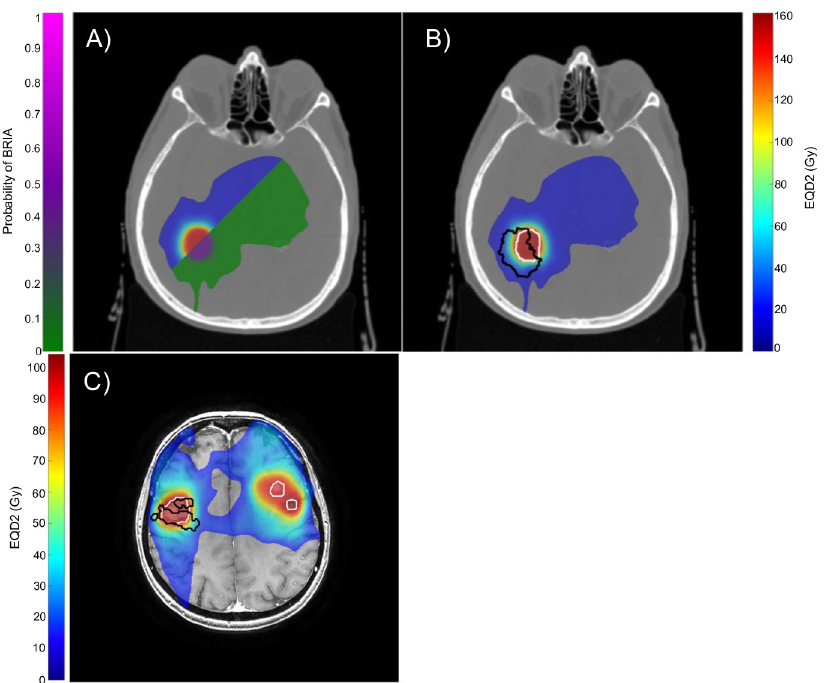
Fig 4. Agreement of the logistic model with the radiation dose map and observed BRIA ROI for two representative patients. Voxel EQD2 is represented by the blue to red scale. Panel A displays the cumulative voxel EQD2 map alongside the estimated probability of BRIA as predicted by the logistic regression model (green to pink scale) in a representative patient. Panel B demonstrates the cumulative voxel EQD2 map overlaid with the PTV (white) and the observed BRIA ROI (black) for the same patient. Panel C illustrates PTVs (white) and observed BRIA ROIs (black) in a second patient. The patient developed BRIA in one of three PTVs. Abbreviations: ROI, region of interest; EQD2, equivalent total dose in 2 Gy fractions; PTV, planning target